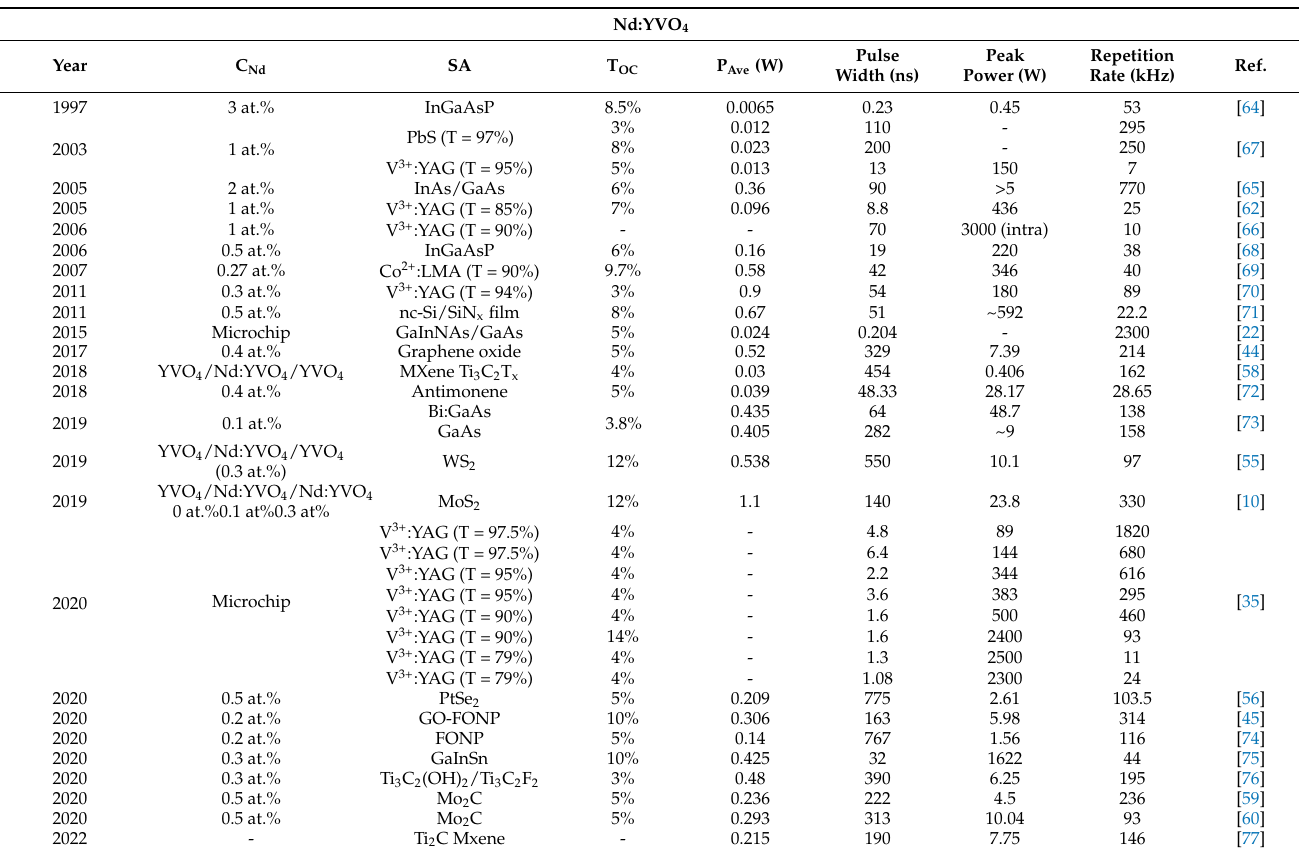
Table 1. Research progress on 1.3 µ m passively Q-switched Nd:YVO 4 lasers.